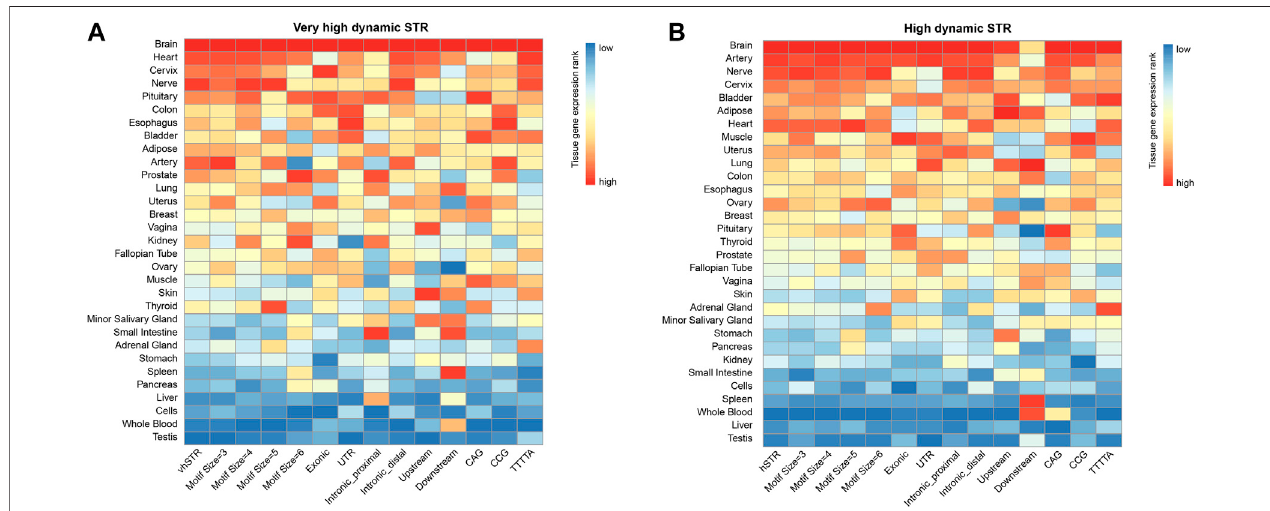
FIGURE 4 | Tissue-speci fi c expression pro fi les of vhSTRs and hSTRs. (A) Tissue-speci fi c expression pattern of vhSTRs. (B) Tissue-speci fi c expression pattern of hSTRs. Heatmaps show the expression patterns of different STRs subset across different tissues based on the normalized expression level. vhSTRs = very highly variable STRs, hSTRs = highly variable STRs. The rows represent the entire dataset of vhSTR or hSTR and their subsets strati fi ed by different motif sizes, genomic regions, and repeat units. The columns represent the tissues.